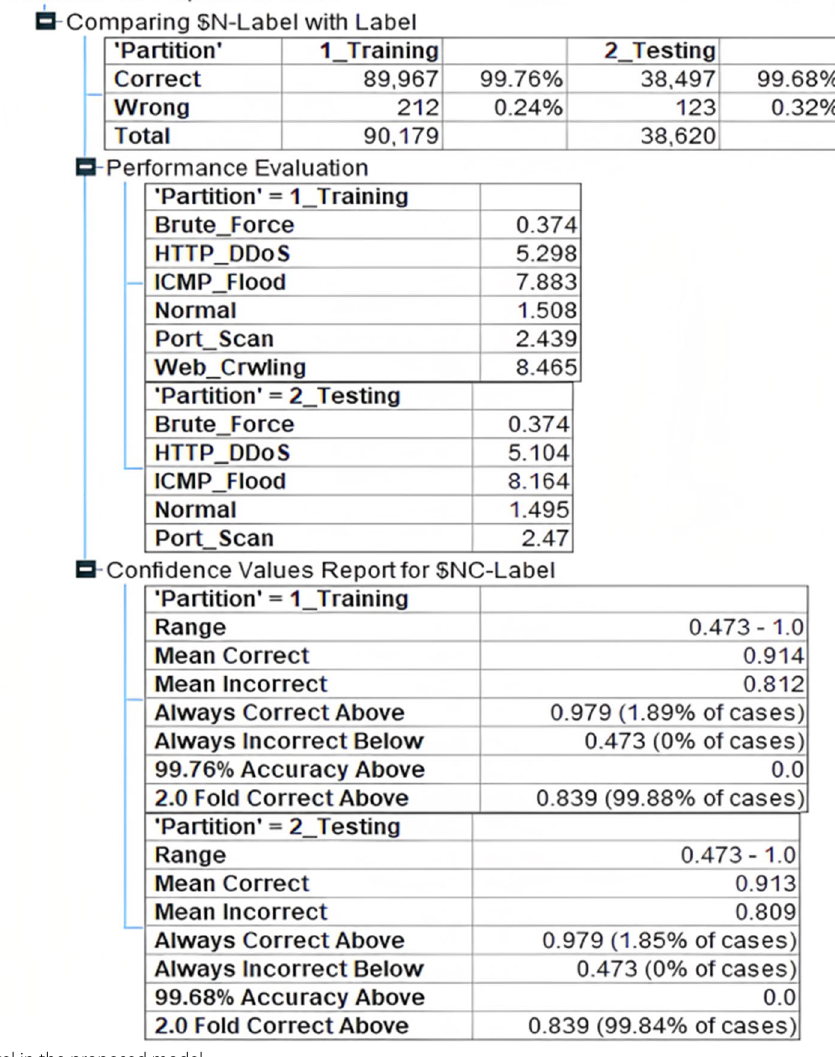
Fig. 12 Accuracy level in the proposed